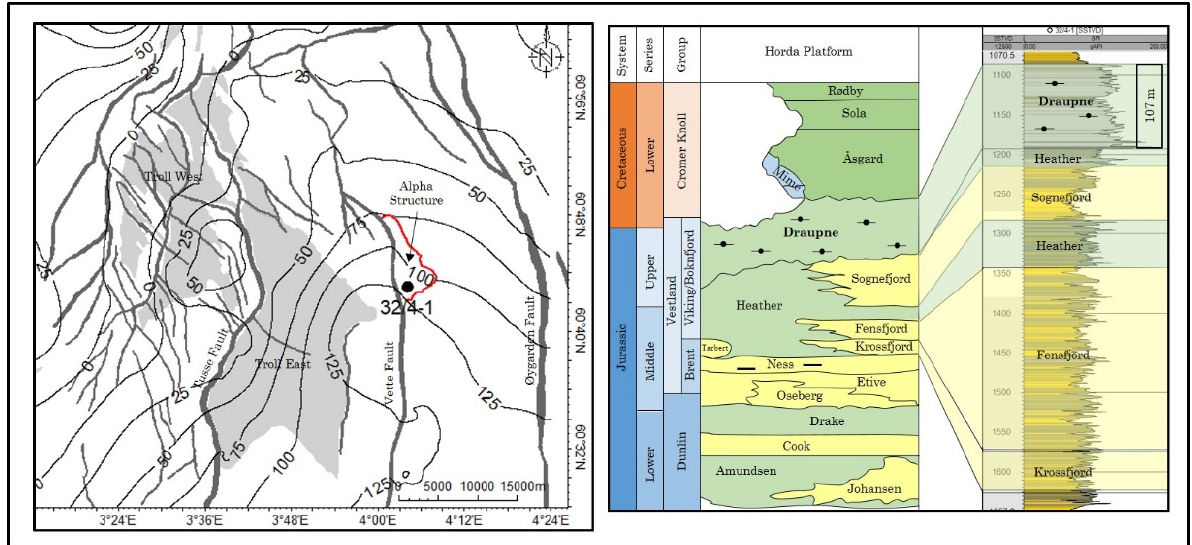
Figure 1. Location map of the Horda Platform, the northern North Sea showing the major and minor faults with Troll fields as reference. The contour lines represent the Draupne Formation thickness adapted from [15]. The red polygon against the Vette fault is the Alpha prospect ( left ). A generalized stratigraphic succession of the Horda Platform showing the Jurassic and Lower Cretaceous formations and the vertical distribution of the Upper Jurassic reservoir-caprock configuration is shown in well 32/4-1 ( right ) (adapted from [16]).